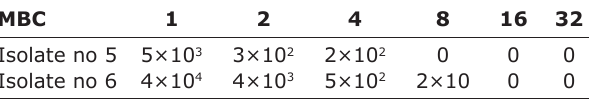
Table-9: Determining MBC of Escherichia coli